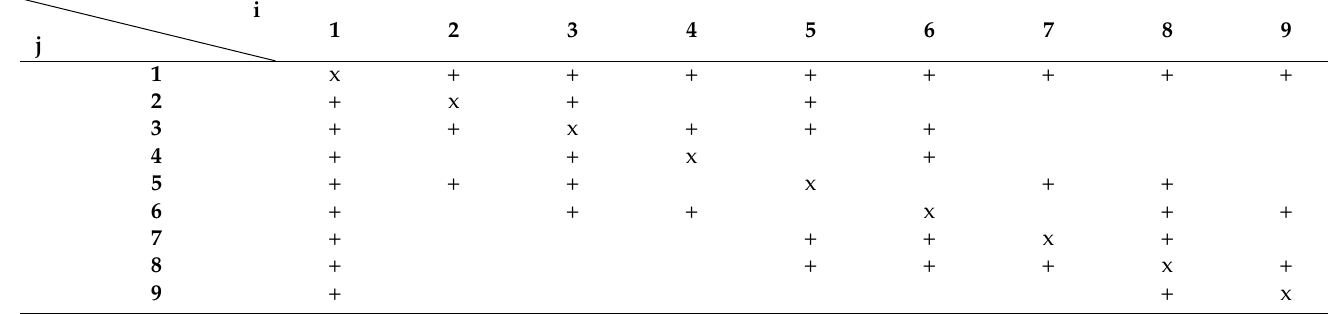
Table 4. Combinations of endpoints of the sections for which the slope angles α HV are